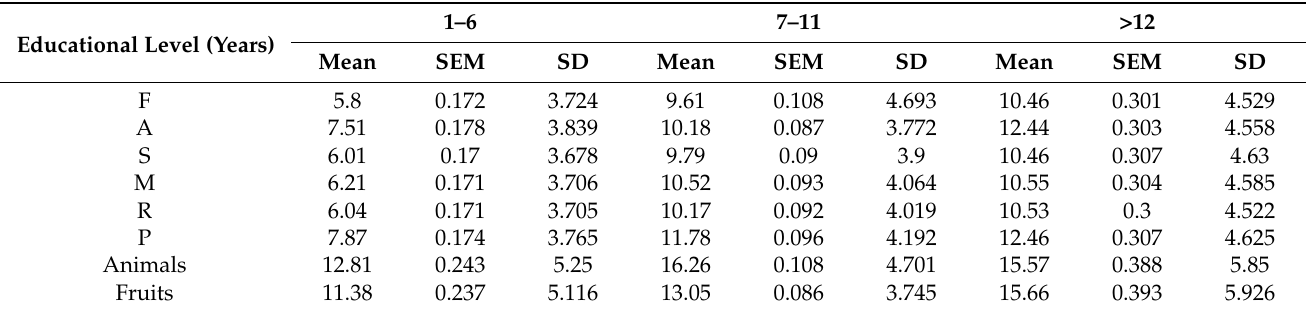
Table 2. Phonologic and semantic verbal fluency of all healthy participants according to educational level